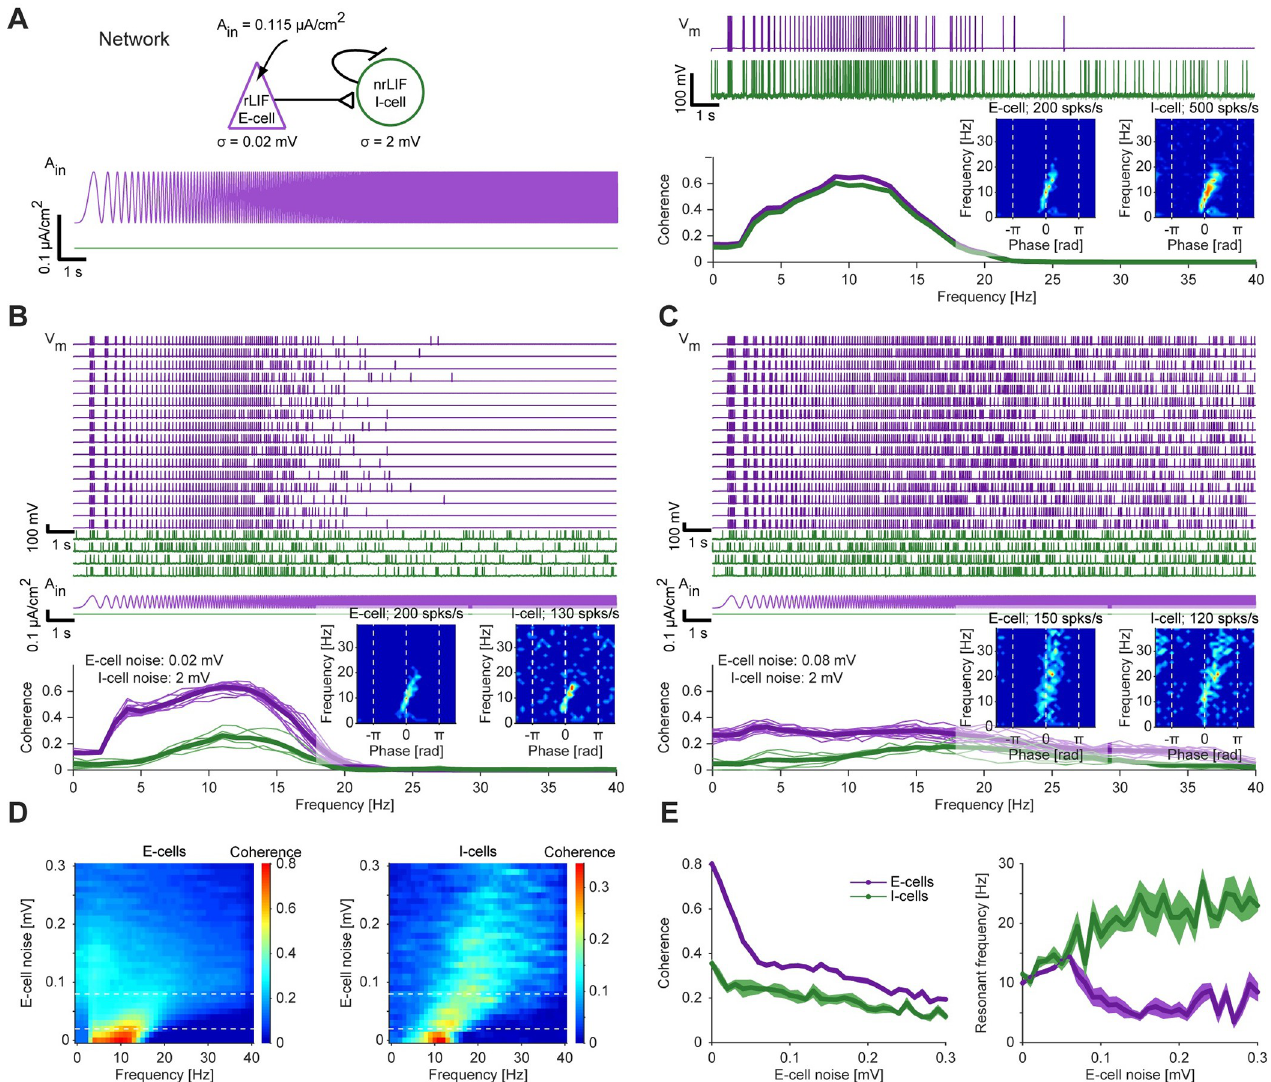
Fig 4. Resonance generated at the spiking level can be inherited to the network level. ( A ) Top left : An E-cell, modeled by an rLIF as in Fig 3B , was connected via an excitatory (AMPA-like) synapse to an I-cell, modeled by an nrLIF. Bottom left : Constant-amplitude periodic current in the form of a linear chirp was applied only to the E-cell (purple trace), that also received low-magnitude noise ( σ = 0 . 02 mV ). Here and in B-E , A in e = 0 . 115 μA/cm 2 . Top right : The I-cell, that received higher magnitude noise ( σ = 2 mV ), exhibits both background and transmitted spikes. Bottom right : Spiking resonance is observed for both model neurons. Inset : Spiking fingerprints for an E-cell and for an I-cell. ( B ) Top : Voltage traces of four target I-cells (nrLIF; green) that received feedforward connections from 16 E-cells (rLIF; purple). All E-cells received exactly the same periodic input current; each cell received independent noise. Bottom : Coherence for every individual model cell (light traces), and averaged coherence for the E-cells (heavy purple traces) and the I-cells (heavy green traces). The indirectly-activated I-cells exhibit spiking resonance. Inset : Spiking fingerprints for an E-cell and for an I-cell. ( C ) The noise level to the E-cells was quadrupled (same network as in panel B ). Spiking resonance of the I-cells is maintained, at a shifted (increased) resonant frequency. Inset : Spiking fingerprints for an E-cell and for an I-cell. ( D ) Coherence of the directly-activated E-cells ( left ) and the indirectly-activated I-cells ( right ), as the magnitude of the noise applied to the E- cell was varied systematically. Horizontal dashed lines indicate the E-cell noise levels used in panels B and C . Each row shows the average coherence (color coded) across 16 E-cells ( left ) or four I-cells ( right ). ( E ) Quantification of the maximal coherence magnitude ( left ) and the peak (“resonant”) frequency ( right ) for the dataset of panel D . Bands show SEM across cells. At low noise levels, E-cell and I-cell exhibit similar resonant frequencies. membrane time constant. Thus, consistent with previous results [13,14], resonance at the level of postsynaptic potentials can be generated without resonance at the level of membrane poten- tial fluctuations.